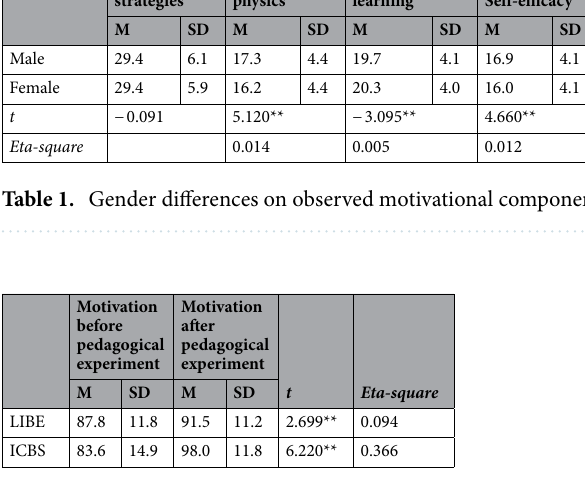
Table 2. Contribution of applied teaching approaches to females’ motivation to learn Physics. ** p <